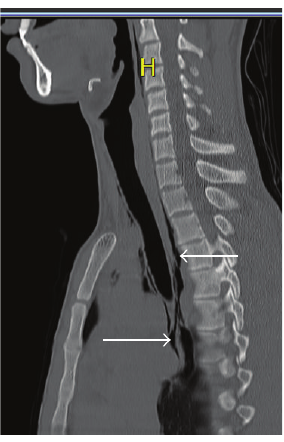
Figure 2: Neck and upper mediastinal CT scan, sagittal section; free air is present around trachea and in mediastinum (arrows).